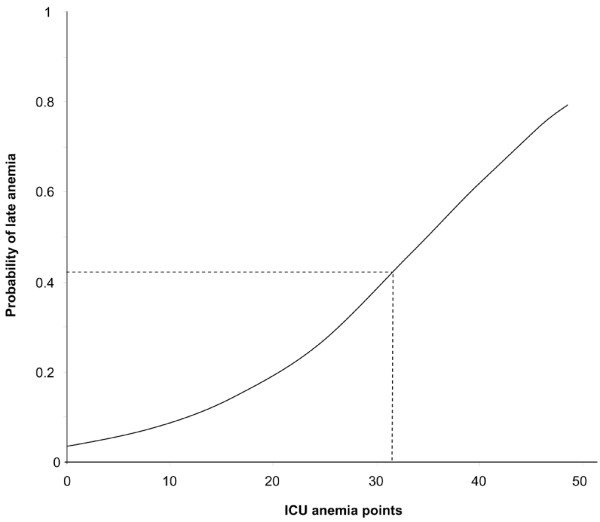
Intensive care unit anemia point system. The correspondence between intensive care unit anemia points (see the text and Table 4) and probability for meeting criteria for late anemia is shown. For example, a surgical patient (11 points) with a lactate concentration of 4.0 g/dl (6 points) and a hemoglobin level of 9 g/dl (15 points) acquires 32 points, which corresponds to a risk of late anemia of 42.4%. The maximum score does not correspond to a probability of 1.00 because patients dying in the first week will never meet late anemia criteria.